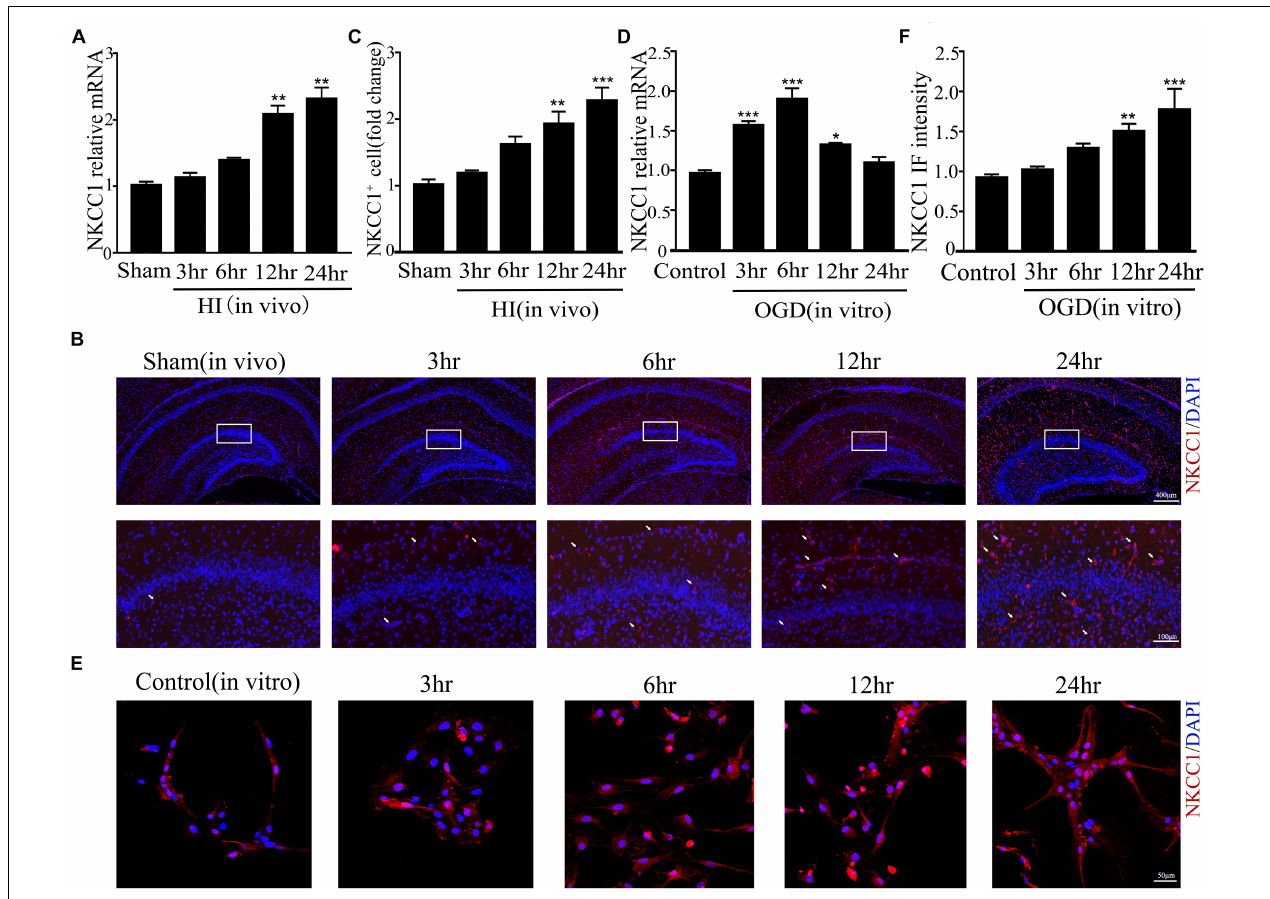
FIGURE 1 | NKCC1 expression after HI and OGD. (A) The NKCC1 mRNA expression level at 3, 6, 12, and 24 h after neonatal HI. The mRNA was collected in the ipsilateral hemisphere from sham and HI groups. (B) NKCC1-positive cells (indicated by white arrows and counterstained with 4 (cid:48) ,6-diamidino-2-phenylindole [DAPI]) were examined in the ipsilateral hemisphere sections at 3, 6, 12, and 24 h, after neonatal HI. (C) The relative number of NKCC1-positive cells in the ipsilateral hemisphere hippocampus. (D) The NKCC1 mRNA expression level at 3, 6, 12, and 24 h in primary cultured hippocampal neurons, after OGD. (E) Confocal image demonstrating NKCC1 expression in neurons. (F) The intensity of NKCC1 was determined in 10 fields/well and divided by the number of cells counterstained with DAPI. The values represent the mean ± SEM. ∗ p < 0.05, ∗∗ p < 0.01, ∗∗∗ p < 0.001 versus control (Tukey’s test after one-way